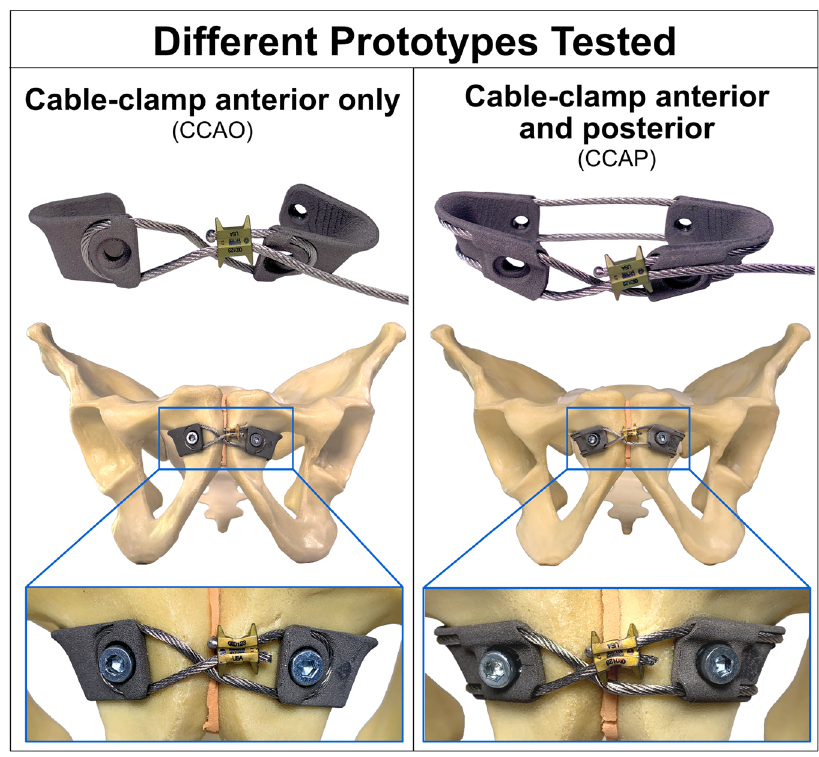
Fig. 1 Cable-clamp fi xation devices for stabilization of a ruptured pubic symphysis. The cable-clamp anterior only (CCAO) design positions the cable anterior to the symphysis. The cable-clamp anterior and posterior (CCAP) design requires the cable to encircle the pubic symphysis. Both clamps contain cable-guiding surface channels and large openings for screw